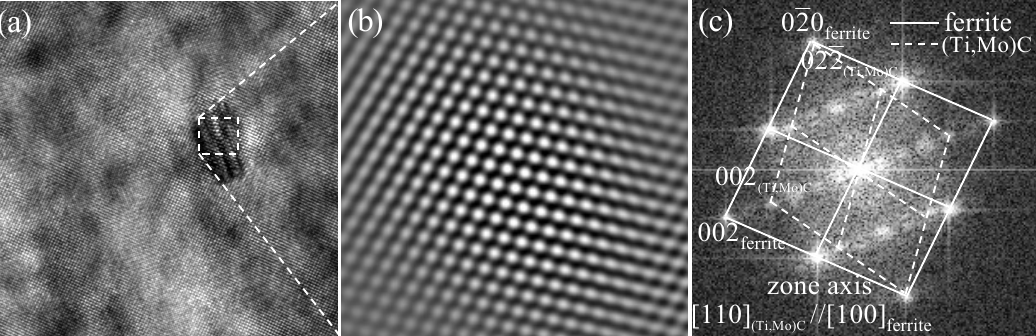
Figure 9. HRTEM image of precipitate and the OR between the precipitates and ferrite matrix in the Ti-Mo steel isothermal holding at 660 °C for 20 min ( a ) HRTEM image; ( b ) iFFT diffractogram; ( c ) FFT diffractogram.